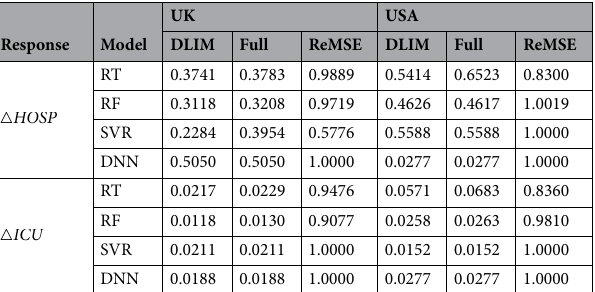
Table 3. MSFE from out-of-sample prediction. Here, DLIML is the distributed lag inspired model and ReMSE is the ratio of MSFE from DLIML and Full